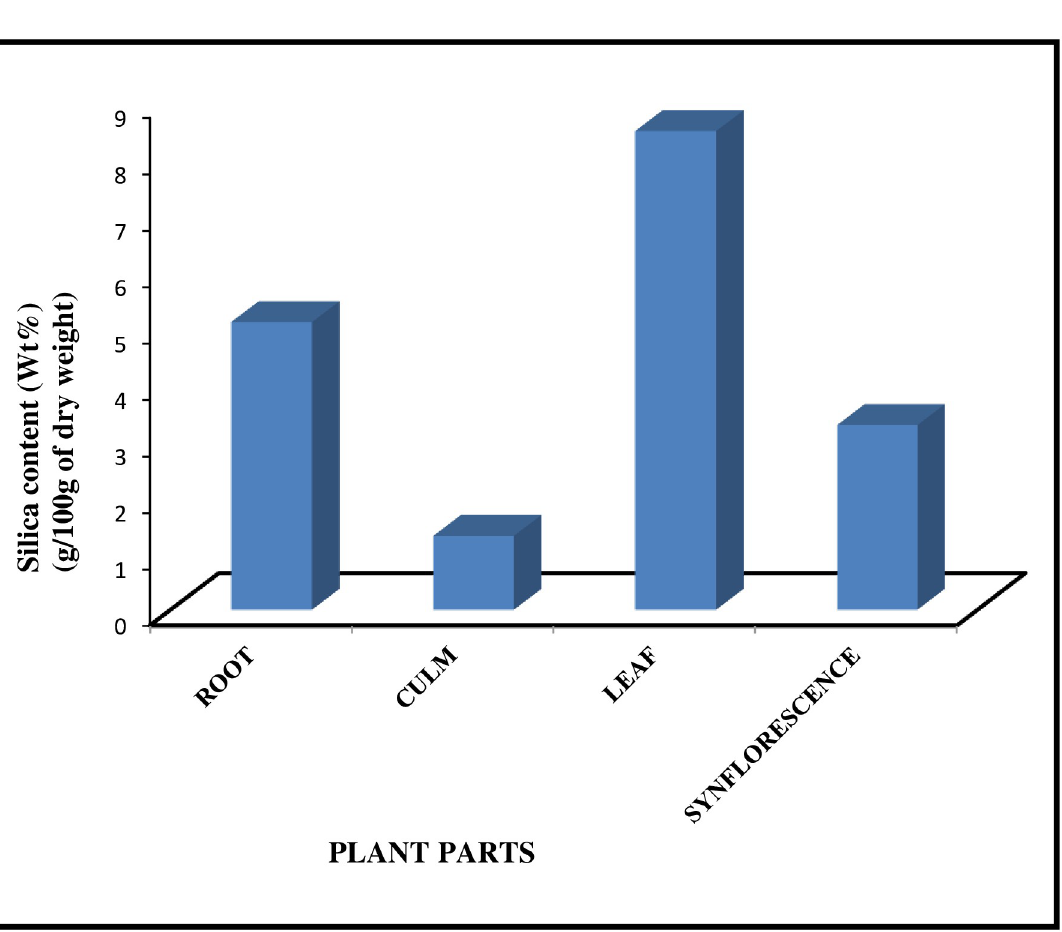
Fig 1. 3D bar-chart showing silica content in various parts of Acrachne racemosa (Heyne ex Roem. & Schult.) Ohwi.